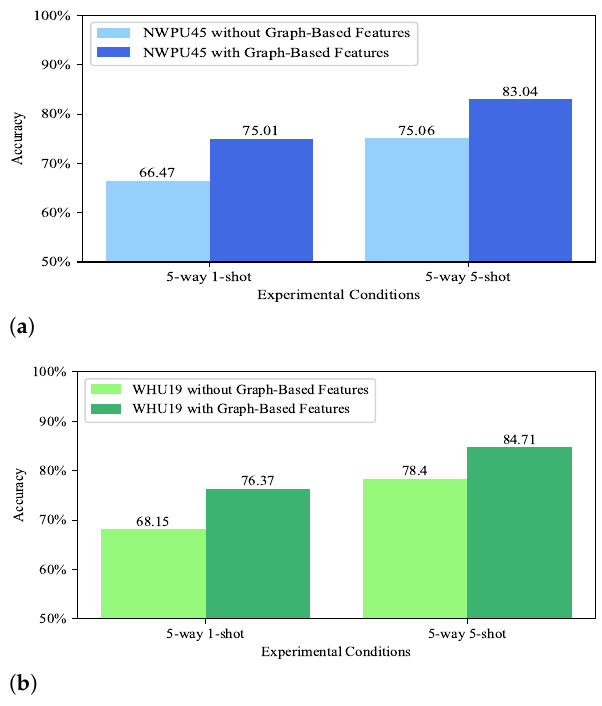
Figure 6. Comparisons of different types of features on two datasets. ( a ) shows the test results on the NWPU-RESISC45 dataset with different types of features, ( b ) shows the test results on the WHU-RS19 dataset with different types of